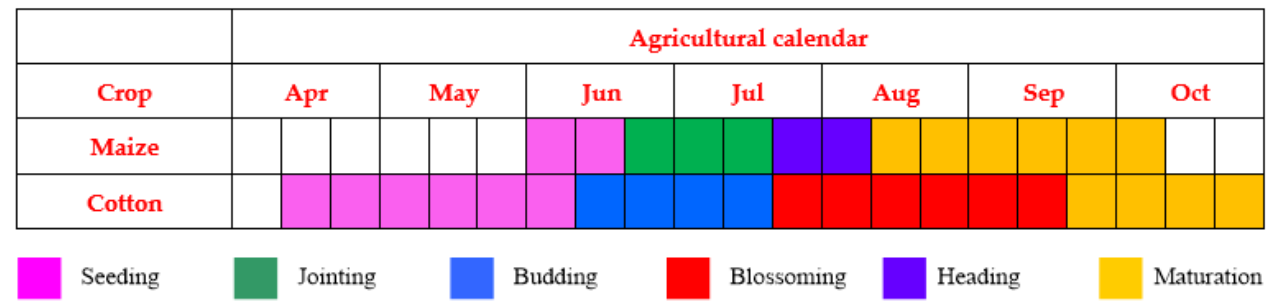
Figure 2. Phenological stages of two dryland crops (maize and cotton) in the study area.